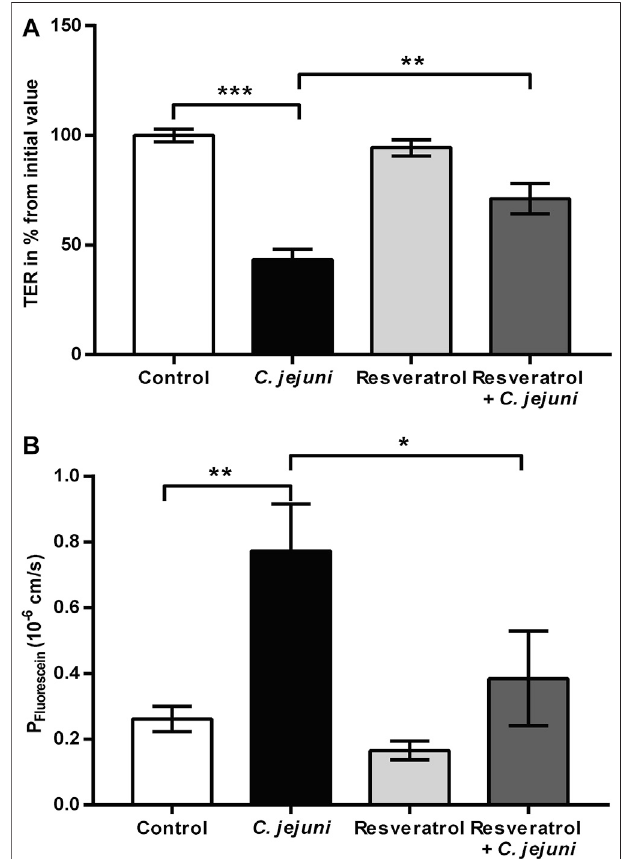
FIGURE 1 | Epithelial barrier function and macromolecule fl ux after Campylobacter jejuni infection in epithelial cell monolayers and after treatment with resveratrol. Human intestinal epithelial HT-29/B6 cells were treated with 100 µM of resveratrol from apical and infected apically with C. jejuni (multiplicity of infection; MOI 100). Transepithelial electrical resistance (TER) was measured with chopstick electrodes 48 h after the infection (A) Resveratrol inhibits the C. jejuni -induced decrease in TER in vitro . Control values after 48 h were set at 100% (n (cid:2) 9 – 10, ** p < 0.01, one-way ANOVA with Bonferroni correction). (B) Resveratrol prevents C. jejuni -induced increase in permeability to fl uorescein(332 Da) in vitro ( n (cid:2) 10, * p < 0.05, ** p < 0.01, one-way ANOVA with Bonferroni